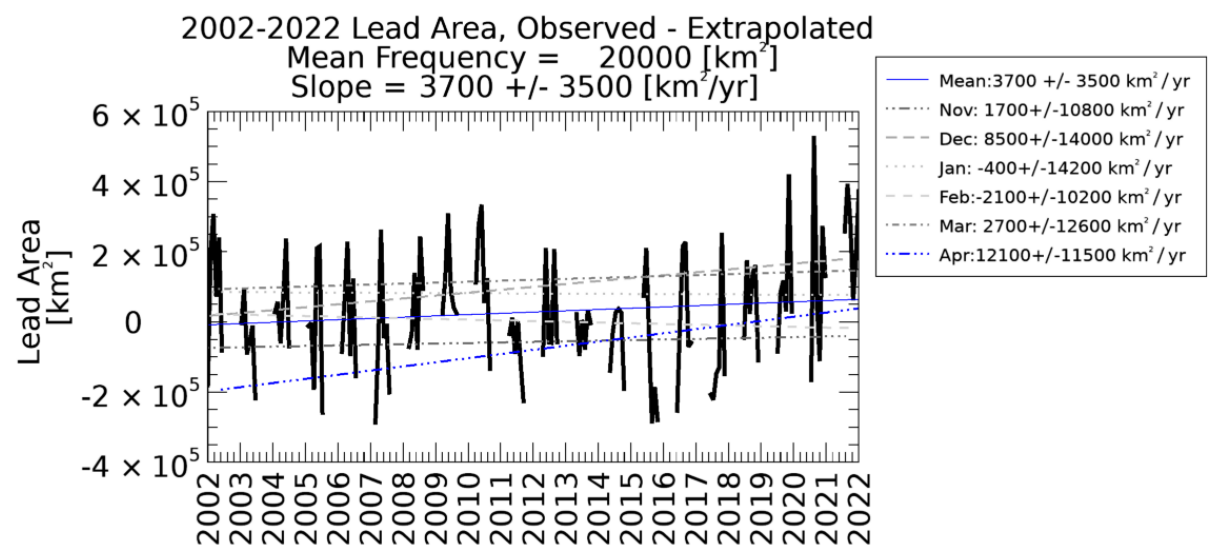
Figure 10. The difference between observed lead areas (from Figure 8, Panel C) and extrapolated leads as a function of clear sky percentage (from Figure 9, Panel B). Statistically significant increases are in blue, and shades of gray are used for months with no statistically significant trend.